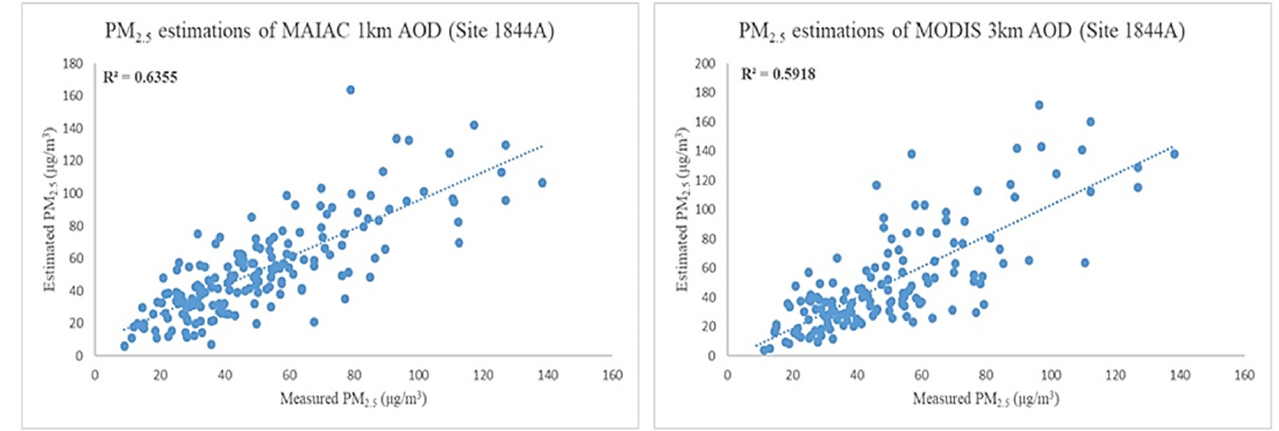
Figure 5. Linear Correlation Analysis of measured PM 2.5 and estimated PM 2.5 , the estimated PM 2.5 are retrieved from MAIAC 1 km AOD and MODIS 3 km AOD.